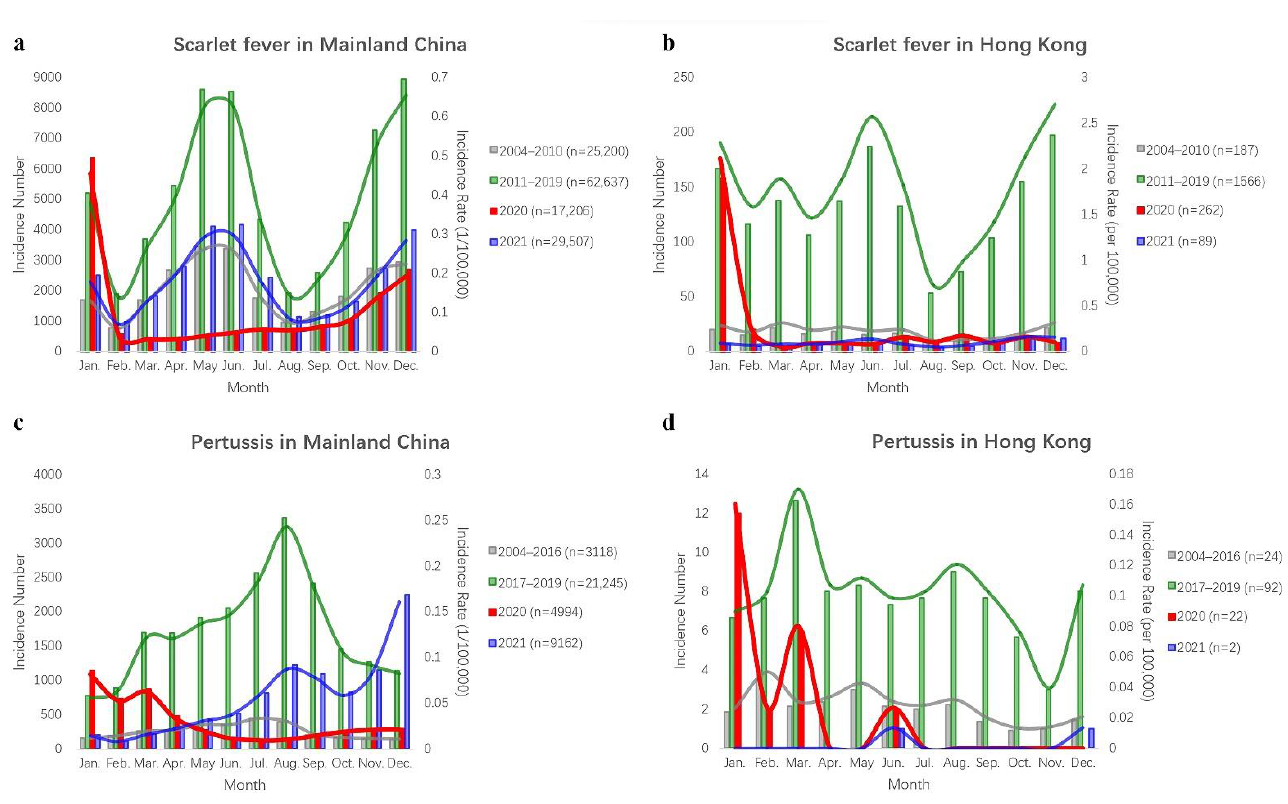
after-re-emergence: 2017 – 2019.